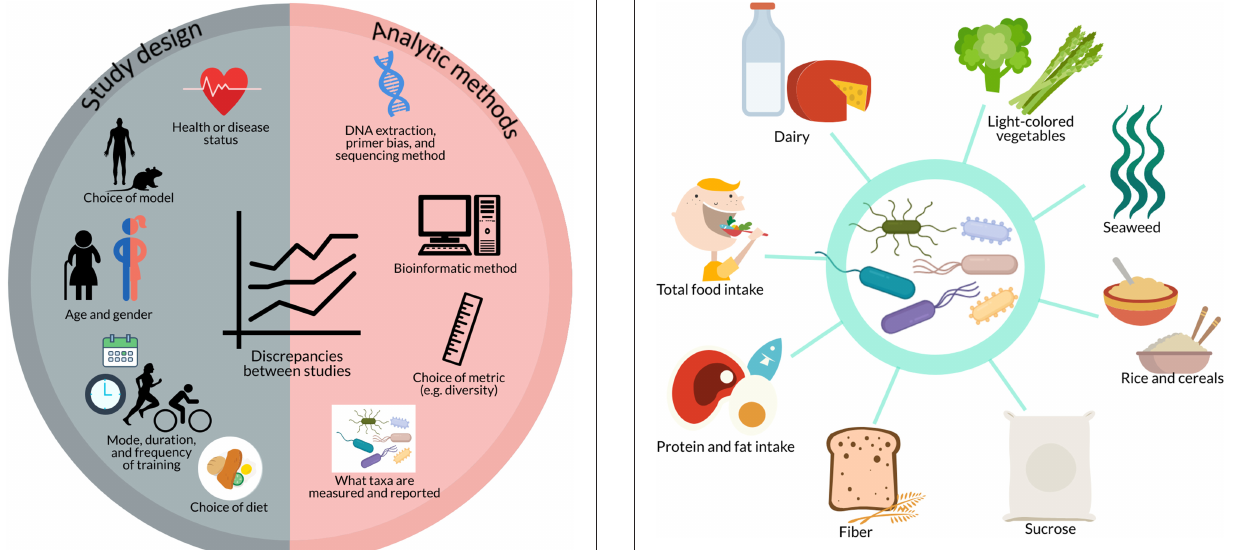
FIGURE 3 | In studies investigating the effect of exercise on the gut microbiome, confounding dietary factors include dairy, light-colored vegetables, seaweed, rice, cereals, sucrose, fiber, protein intake, fat intake, and total food intake. 109). In addition to whole food forms of carbohydrates, such as bread, pasta, fruit, and potatoes, there is also a wide